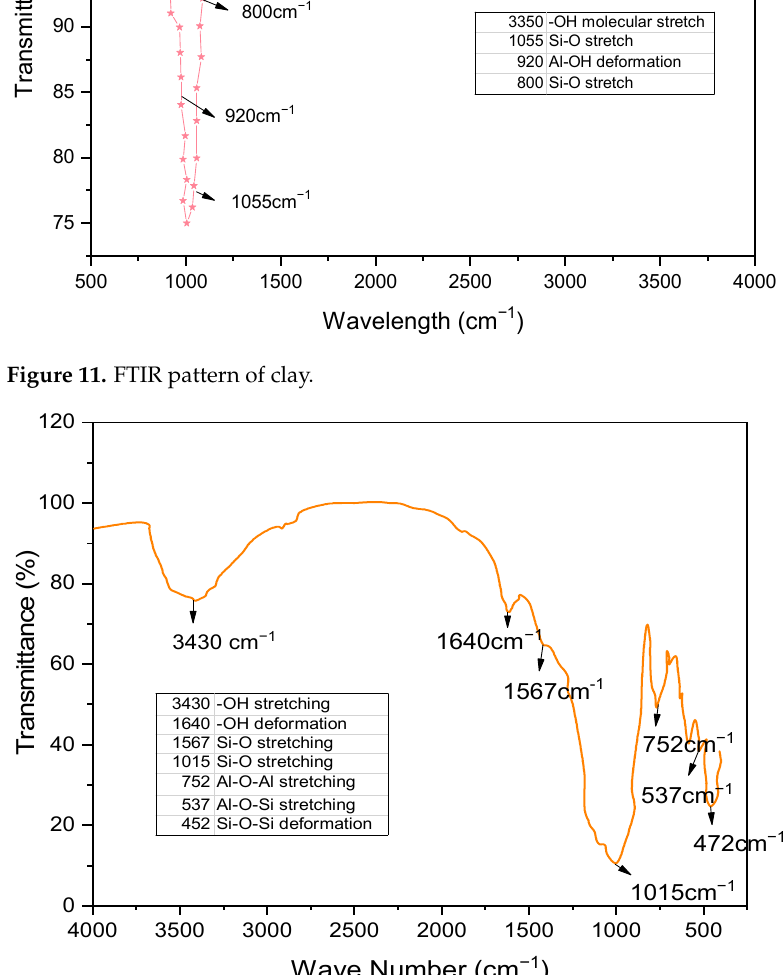
Figure 12. FTIR pattern of granite sand.